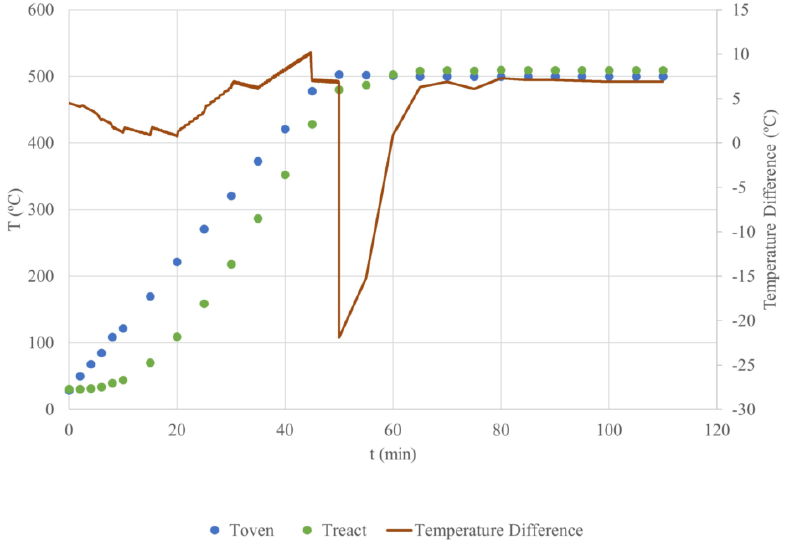
Figure 3. Temperature profile for the isothermal reactor containing the cork sample, corresponding temperature in the oven, and temperature difference between the reactor containing the sample and the empty reactor for the same temperature program.